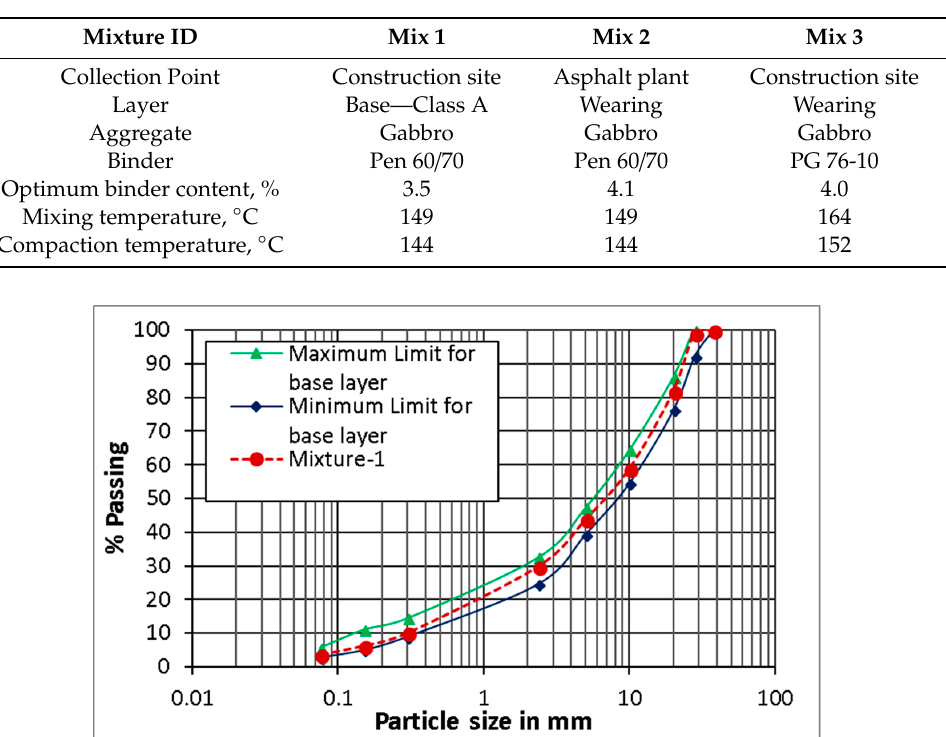
Table 1. Mixture characteristics.